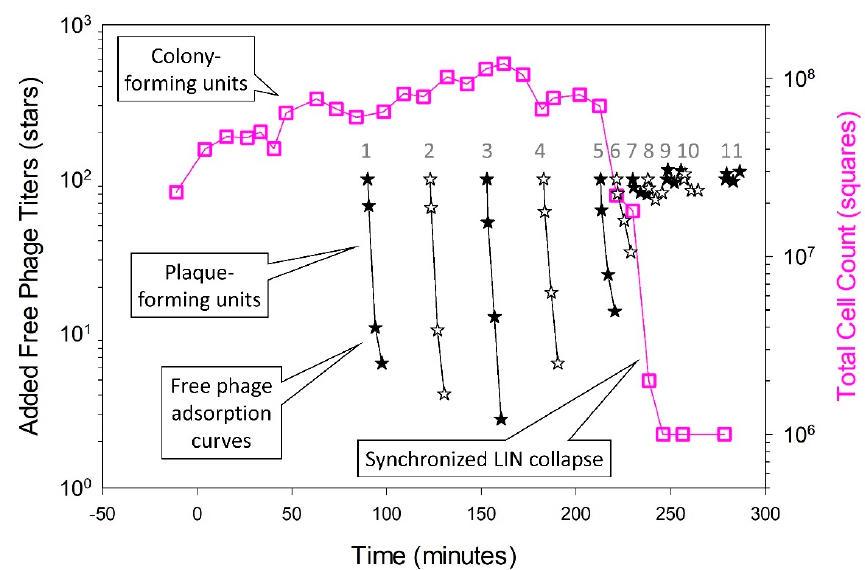
Figure 6. Impact of lysis inhibited T4-infected bacteria on free T4 phages. Lysis inhibition-expressing, double amber mutant T4 phages ( 42amNG205 × 43am4306 ) were added at time zero to E. coli CR63 bacteria (an amber-suppressing strain) with a multiplicity of 0.2. The resulting phage infections were then followed by both turbidity (blue circles, top panel) and total cell count per ml (pink squares, top and bottom panels). At various intervals, aliquots of culture were removed to which wild-type, free T4 phages (T4D) were added at low multiplicity (<<1). These now-separate cultures were then followed in terms of titers using non-amber suppressing E. coli K12 wild-type indicator bacteria (stars, bottom panel; titer data normalized to a staring density of 100 = 10 2 plaque-forming units/mL; T4D is a wild-type laboratory strain of phage T4). E. coli K12, unlike E. coli CR63, is non-permissive to the double amber mutant phages and therefore upon plating only the added T4D phages, particularly as free phages, are able to form plaques. Thus, the generated starred curves are a series of added T4D-only free-phage adsorption curves [55]. Indicated are declines in T4D titers over 7.5-min spans, for a total of 11 such curves (all shown, lower panel). Note that rates of decline in titers are drastically reduced once culture lysis has occurred, i.e., after approximately 225 min; see especially curve numbers 7 through 11 for indication of this reduced rate of decline. Note that the increase in total cell counts observed between roughly 50 and 150 min is not seen consistently in all experiments [18]. An equivalent experiment is published in Abedon [6] and both were performed by David Brennan working under my